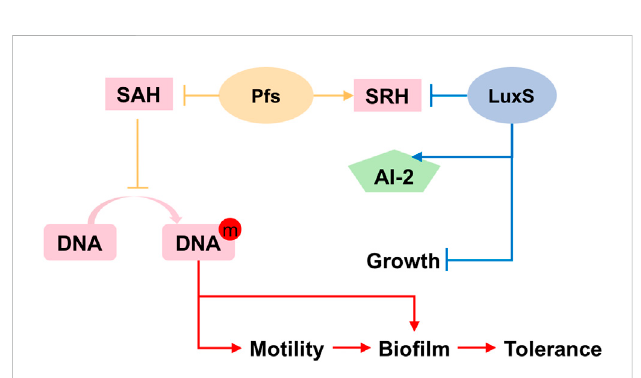
FIGURE 8 Proposed mechanism of Pfs and LuxS on AI-2 production, motility, bio fi lm formation, and stress